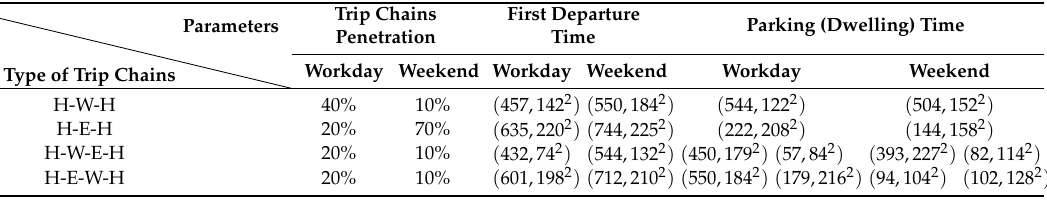
Table 7. Parameters of start time and dwell time of each trip purpose for di ff erent trip chains.